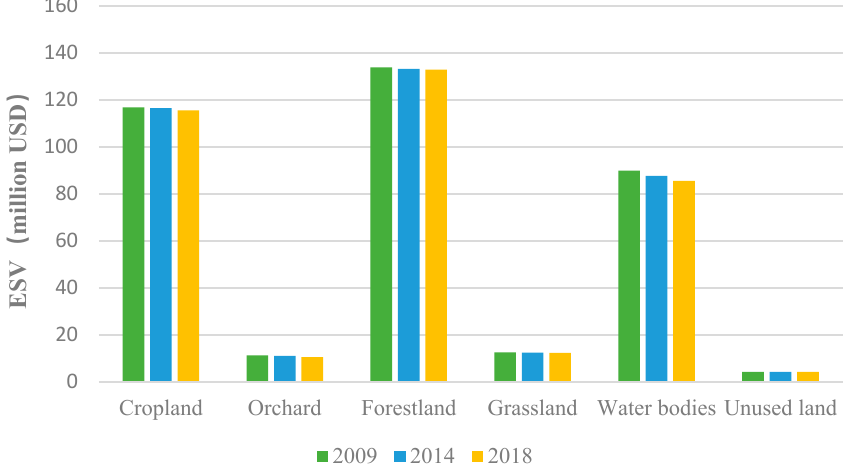
Figure 4. The ESV for different land use types from 2009 to 2018.